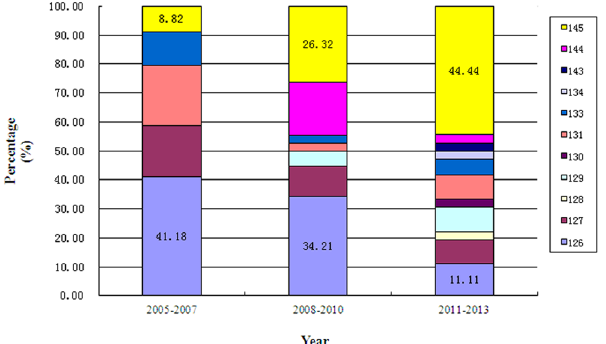
Figure 2. Percentage of different amino acid position mutations within “ α ” determinant of HBsAg from 2005 to